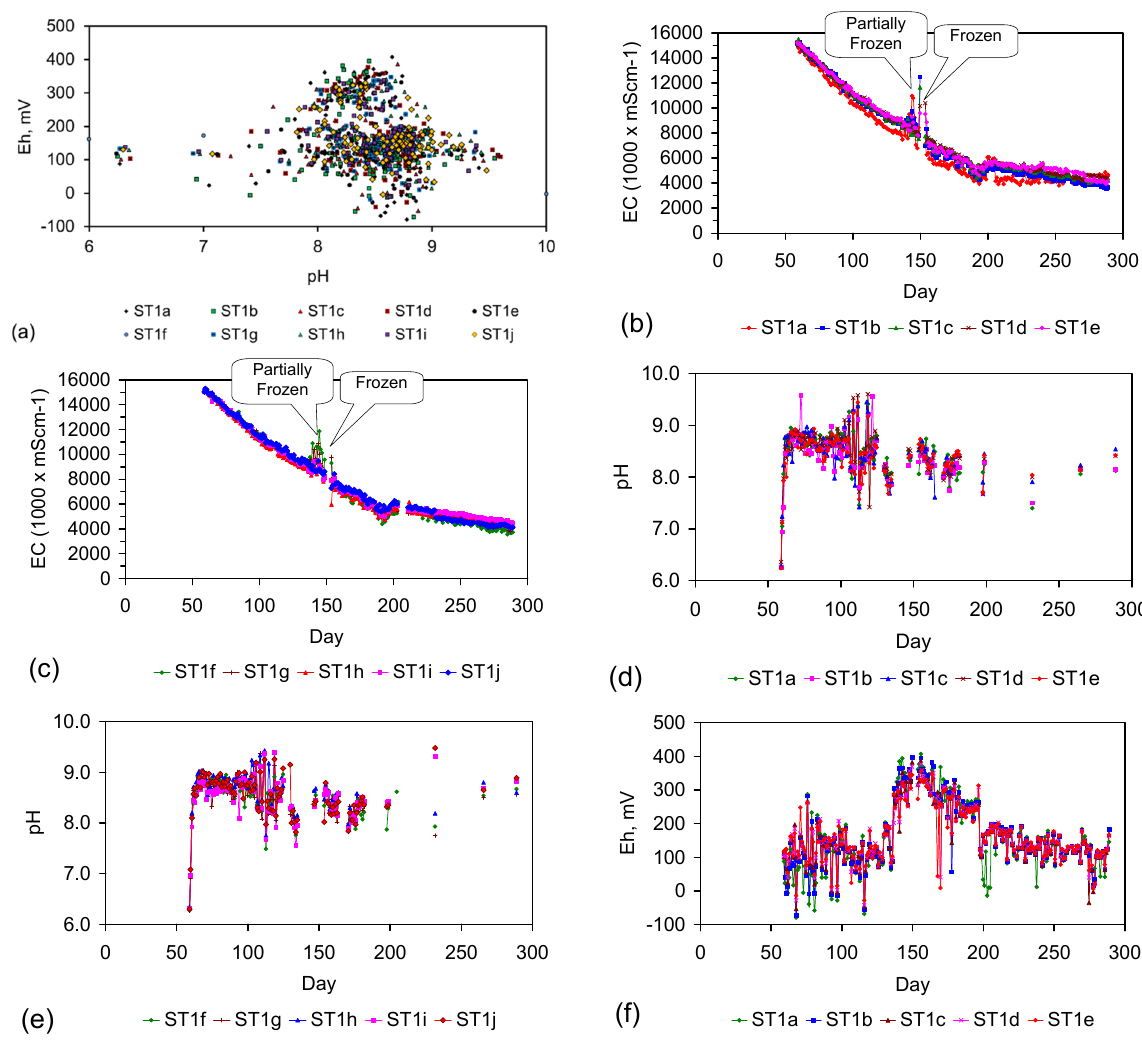
Figure C4. ( a ) EC vs. day; ( b ) Eh vs. day; ( c ) pH vs. day; ( d ) pH vs. Eh. AS4 = 42 g·L − 1 ;